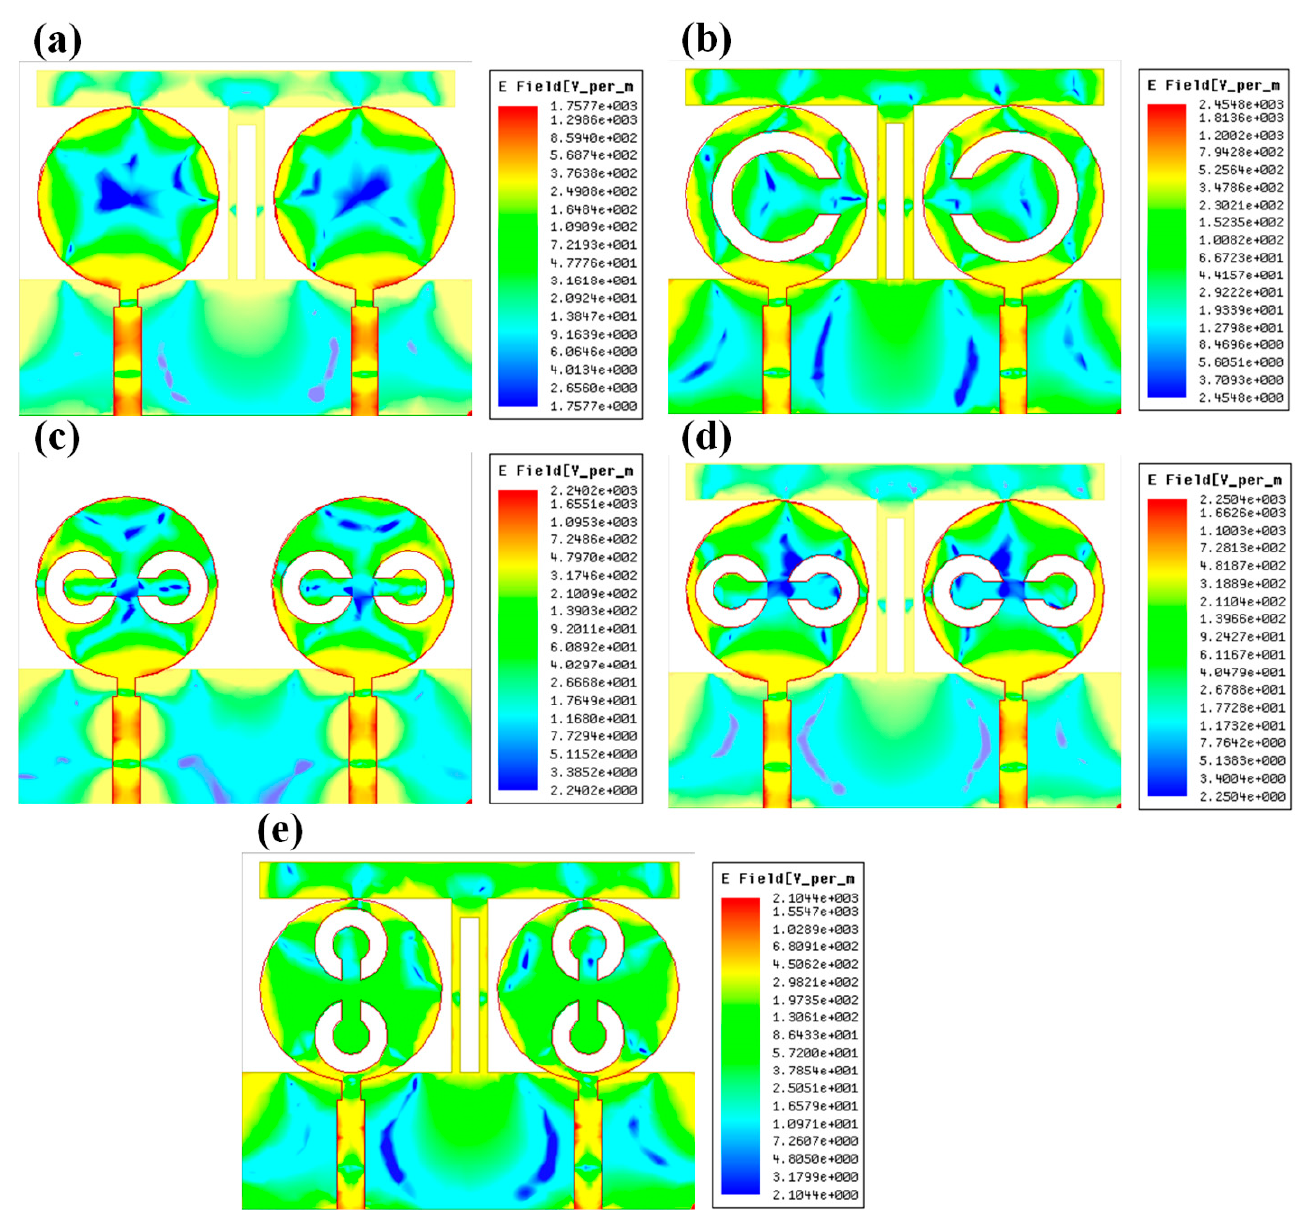
Figure 9. Normalized electric field distribution for the different shapes of the structures. The normalized electric field intensity for the different antenna designs ( a ) Design 1, ( b ) Design 2, ( c ) Design 3, ( d ) Design 4, and ( e ) Design 5 for the 10 GHz frequency value.